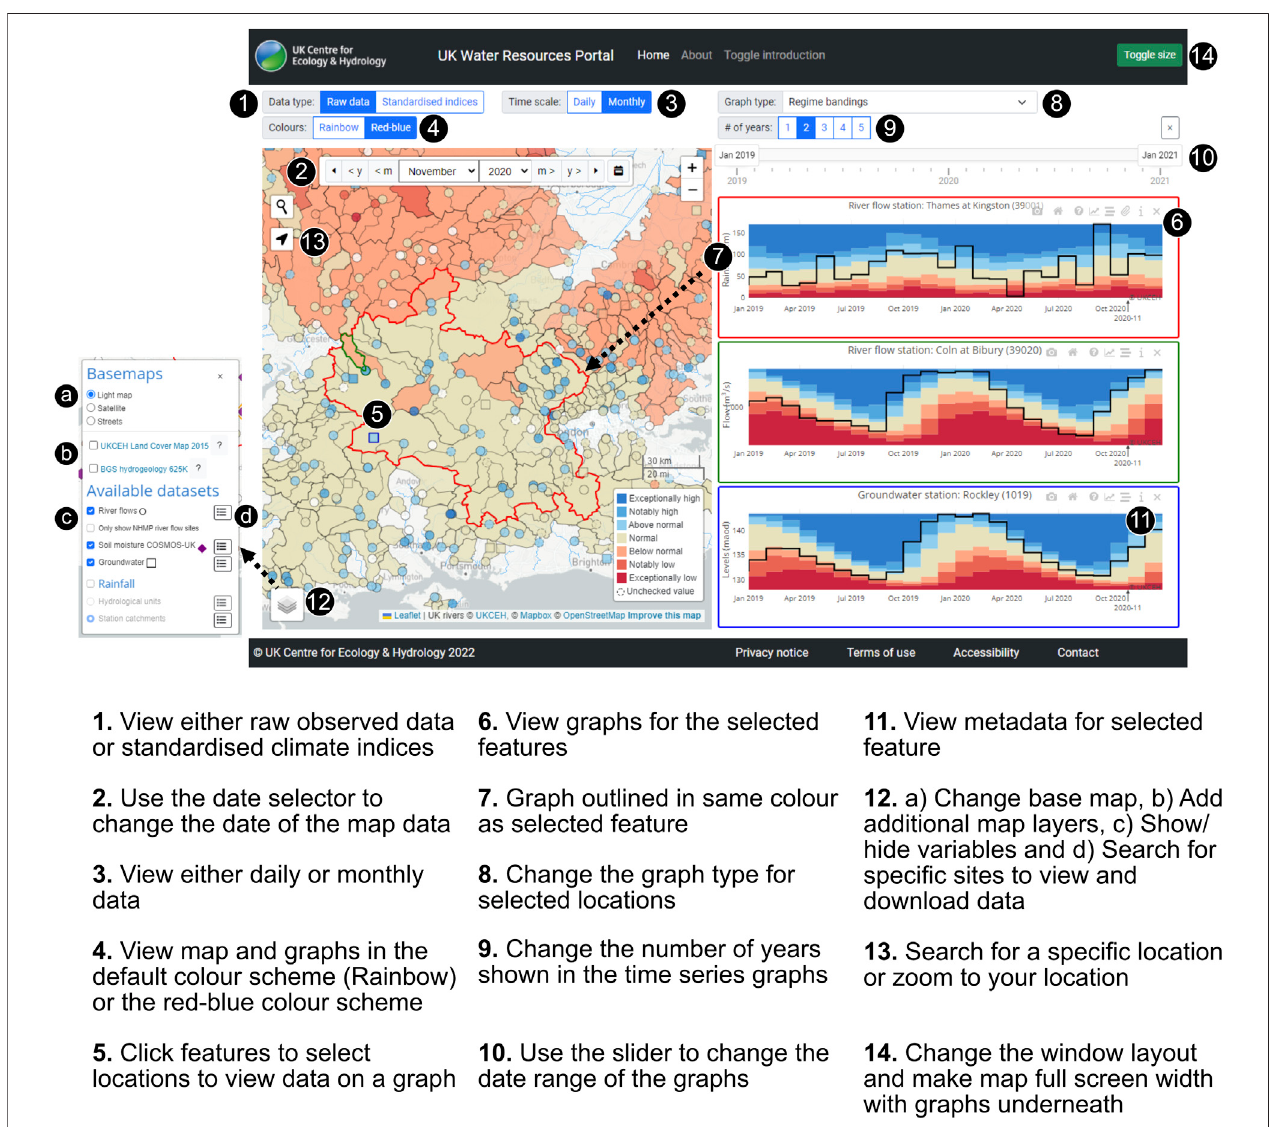
FIGURE 3 | Summary of UK Water Resources Portal functionality and